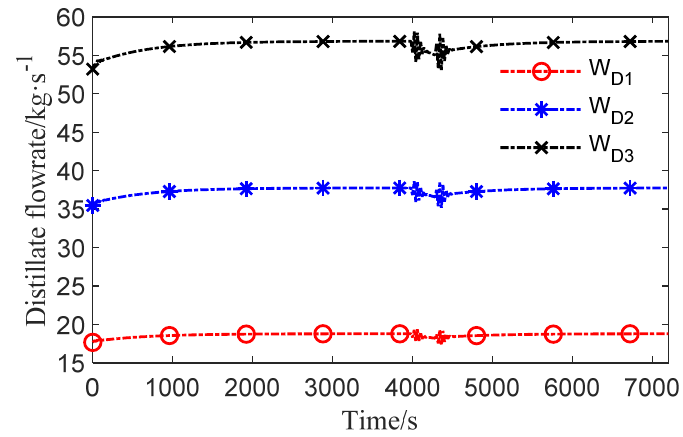
W T Figure 16. Dynamic of W D 1 , W D 2 , W D 3 for step increase in T sea . Figure 16. Dynamic of for step increase in sea . The dynamic responses of TBT, BBT, and T B 1 , T B 2 , T B 3 are shown in Figures 13–15. The figures show that the rise of the above parameters is smaller than that of the distur- bance. The increase in T sea reduces the overall temperature drop of the device, indicating a decrease in the heat consumption of the flashing brine in the system. According to the law of conservation of energy, the heat lost by the flashing brine will be converted into the heat absorbed by the flashing steam, resulting in less distillate. Therefore, as shown in Figure 16, when the disturbance occurs, W D 1 , W D 2 , W D 3 will first decrease and then in-